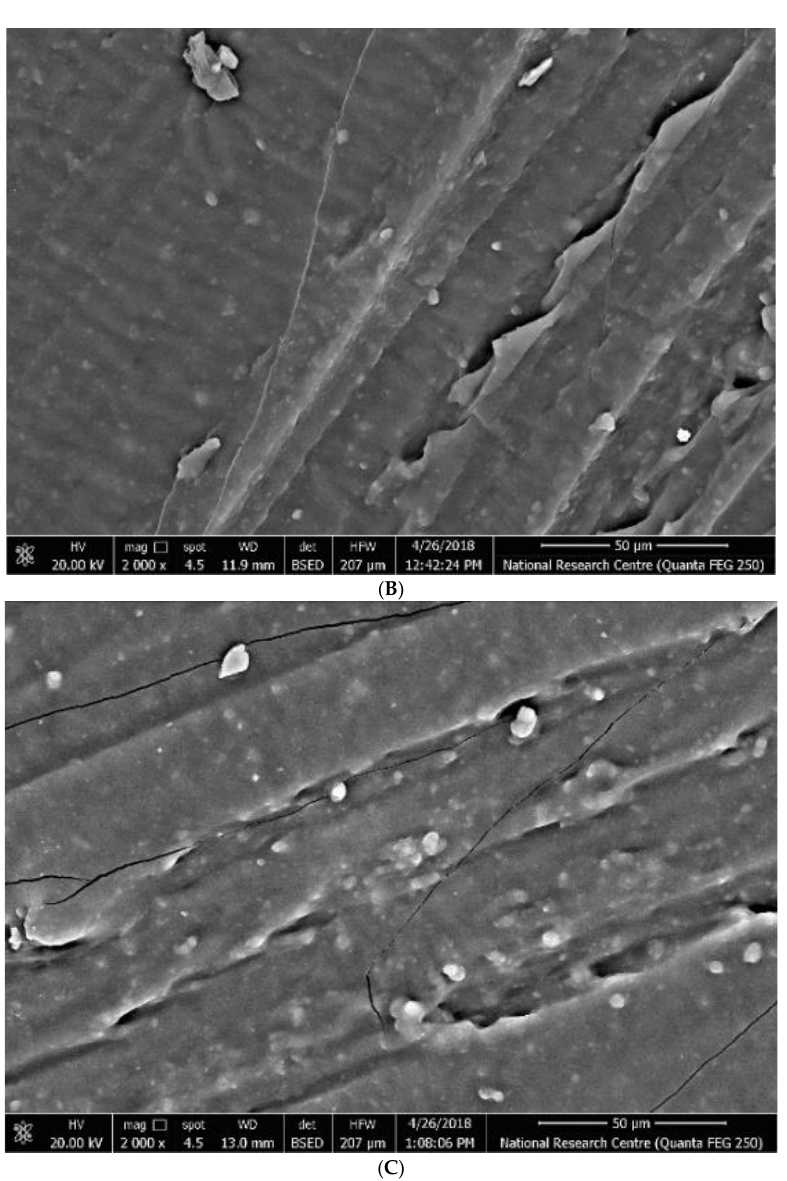
Figure 2. SEM images of silicone rubber nanocomposite samples, ( A ) 0.5% SiO 2 , ( B ) 0.5% TiO 2 , ( C ) 0.5% ZrO 2 . ( C ) 0.5% ZrO 2